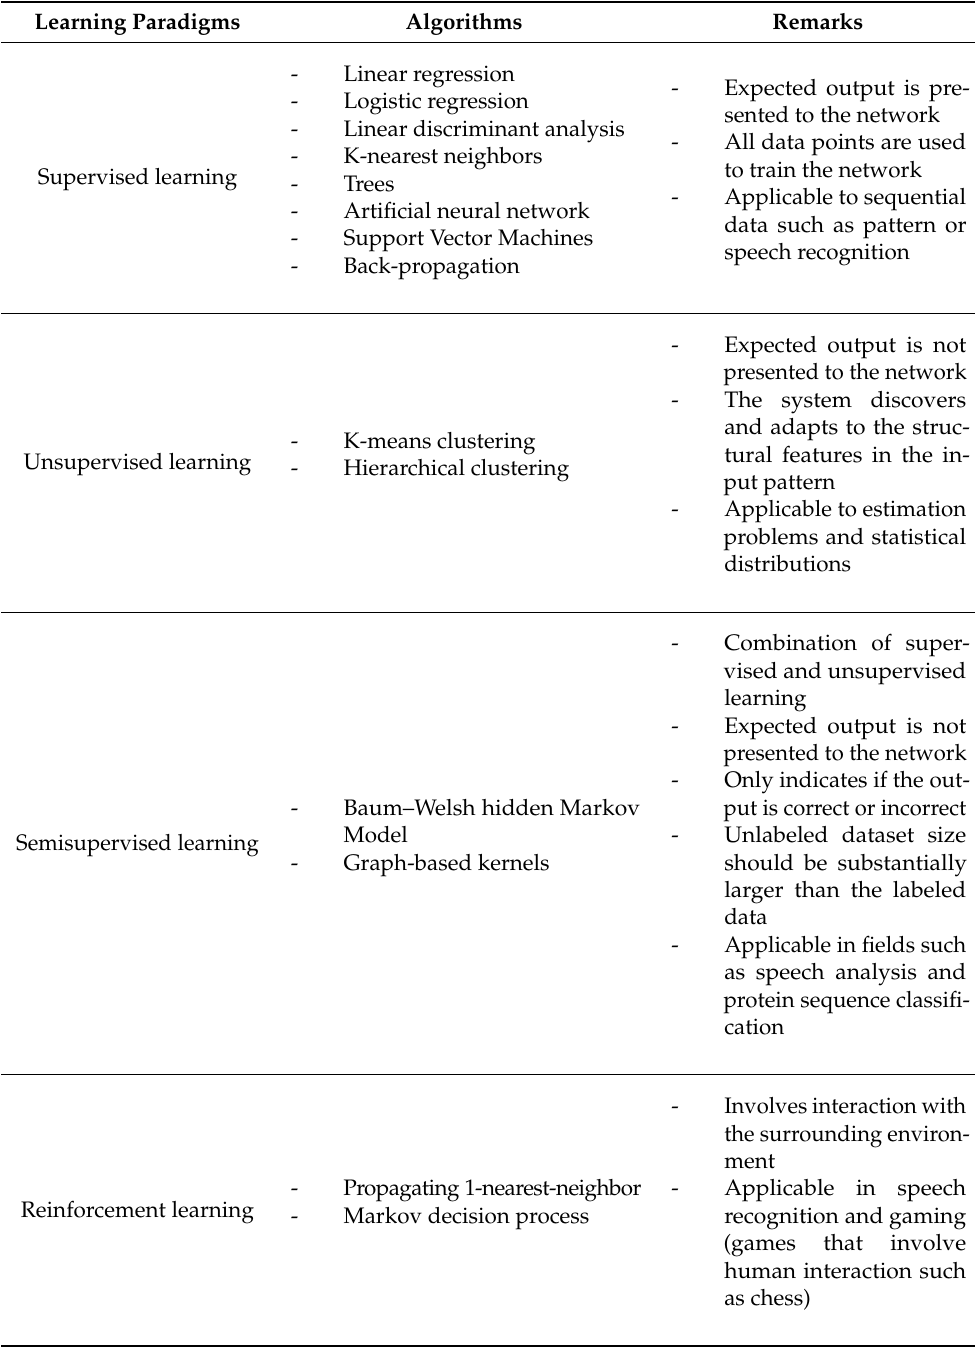
Table 4. Machine learning paradigms